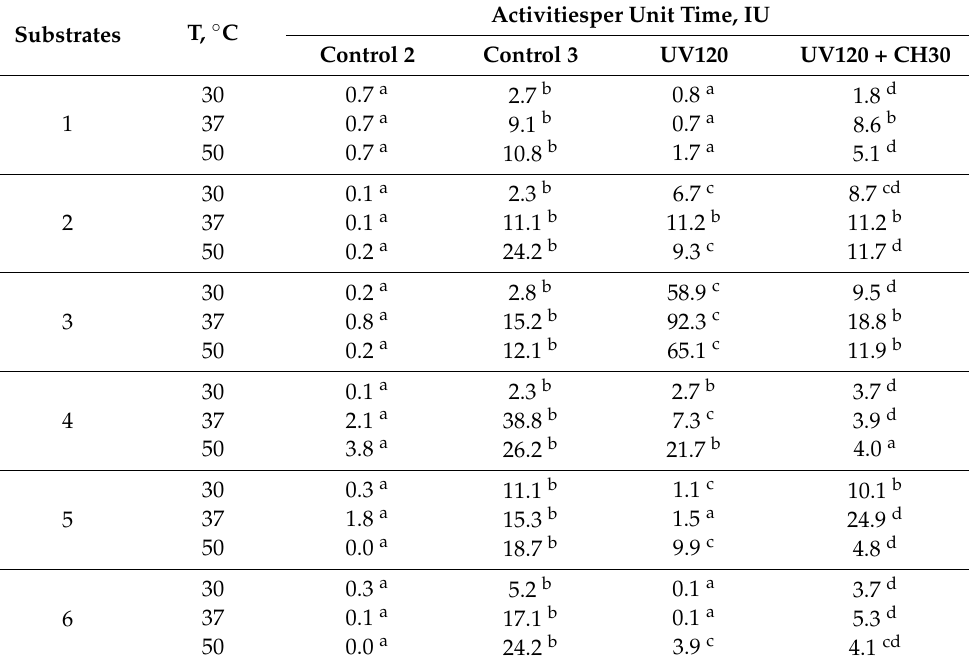
Table 7. Comparison of the enzymatic activity of microorganisms. Activitiesper Unit Time, IU Substrates T, ◦ C Control 2 Control 3 UV120 UV120 +